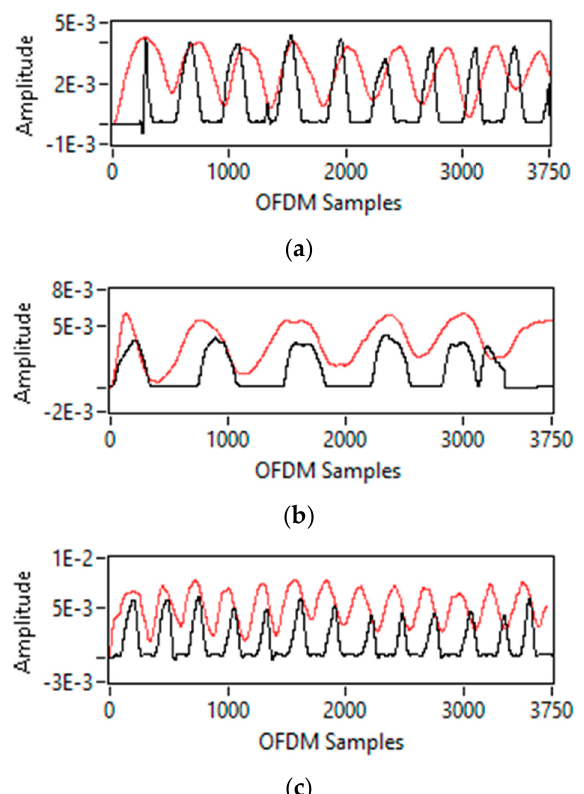
Figure 7. Breathing patterns detection for single person-scenario (non-contact sensor (Red) vs. Wearable sensor (Black): ( a ) normal breathing; ( b ) slow breathing; and ( c ) fast breathing.